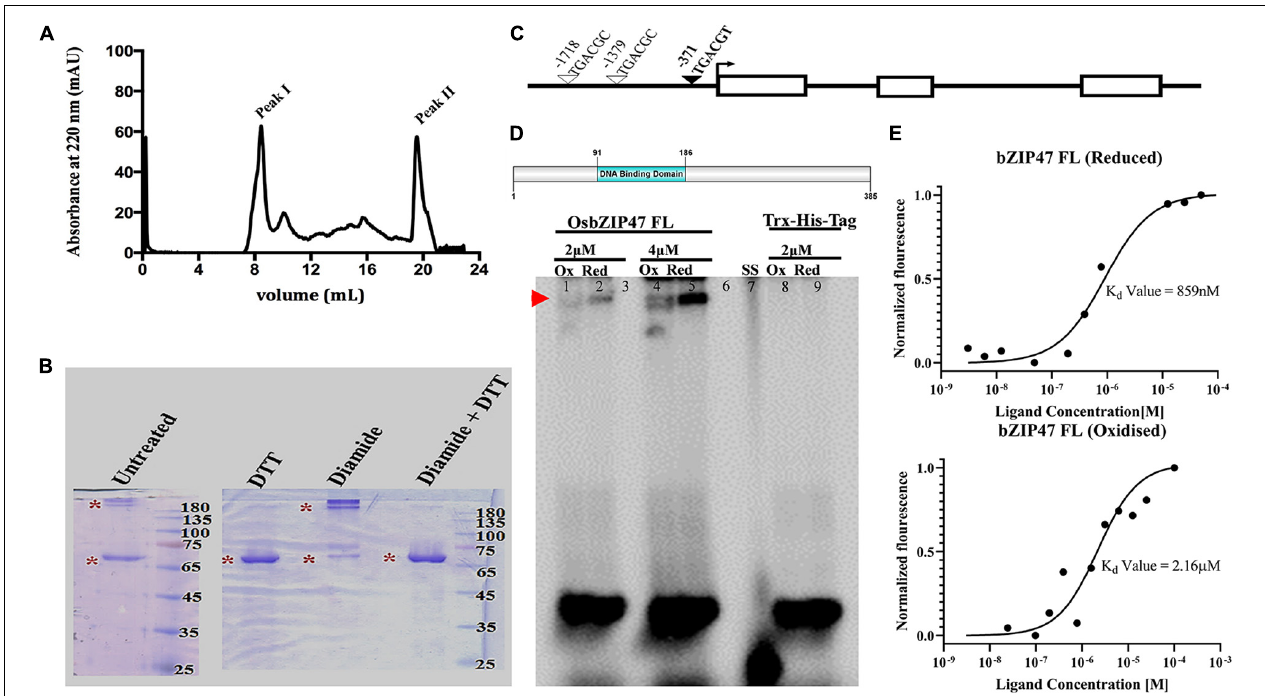
FIGURE 7 | OsbZIP47 oligomerization and the effects of its redox status on DNA binding. (A) Size-exclusion chromatography (SEC) profile for OsbZIP47 protein/oligomer on a Superdex 200 increase column. (B) Mobility of purified OsbZIP47-Trx protein on non-reducing 10% of SDS-PAGE after treatment with 2 mM of diamide (an oxidizing agent), or with 20 mM DTT (a reducing agent), or with 2 mM diamide followed by 20 mM DTT. (C) Schematic representation of the FCP1 gene locus. Exons are open white boxes, introns are shown as black lines, and the predicted cis motifs for bZIP DNA binding domain (DBD) are represented as inverted triangles. The DNA binding properties of OsbZIP47FL protein was tested for the TGACGT cis motif located at -371bp of FCP1 (marked with a filled inverted triangle). (D) Schematic representation of OsbZIP47 FL protein (amino acid 1 to 385) used for EMSA and microscale thermophoresis assays. EMSA assays with full-length OsbZIP47 (62 Kda protein) shows retarded mobility of DNA-protein complex for the OsFCP1 locus (as indicated by red arrow). Lanes 1 and 2 correspond to the oxidized and reduced form of bZIP47 FL protein incubated with 2 µ M of oligo. Lanes 4 and 5 represent the oxidized and reduced form of the same protein, incubated with 4 µ M of oligo. Lanes 8 and 9 correspond to Trx-Tag protein incubated with 4 µ M of probe. Lanes 3 and 6 are blank. Unbound dsDNA oligonucleotide is at the bottom. (E) Microscale thermophoresis-based assay to determine the dissociation constant for OsbZIP47 full-length and OsFCP1 dsDNA oligo interaction. 80 nM of fluorescently labeled protein was taken for binding with DNA sequences from OsFCP1 locus taken at a wide concentration range (100 µ M to 3.05 nM). The OsbZIP47 full length protein was reduced with 20 mM DTT or oxidized with 1mM of oxidized glutathione. OsbZIP47 full length protein shows increased binding in the reduced state as compared to the oxidized